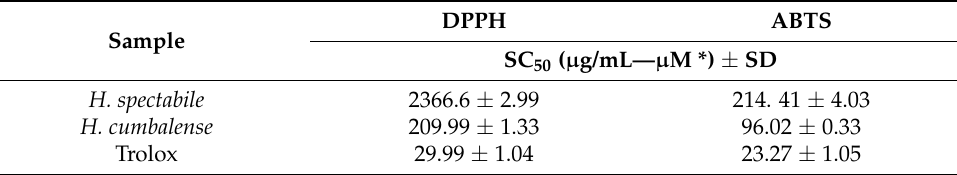
Table 5. H. cumbalense and H. spectabile essential oils antioxidant activity.